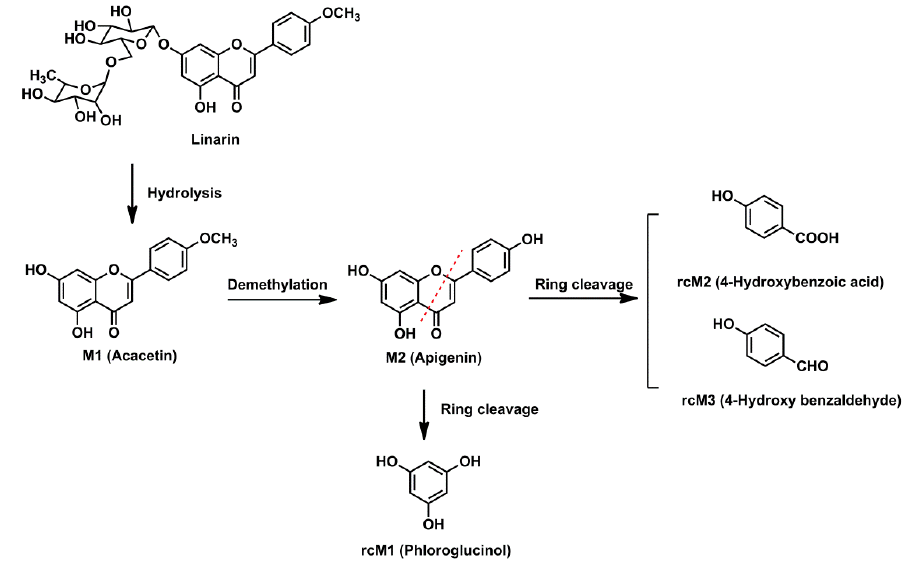
Figure 4. Proposed metabolic pathways of linarin in rat intestinal flora.